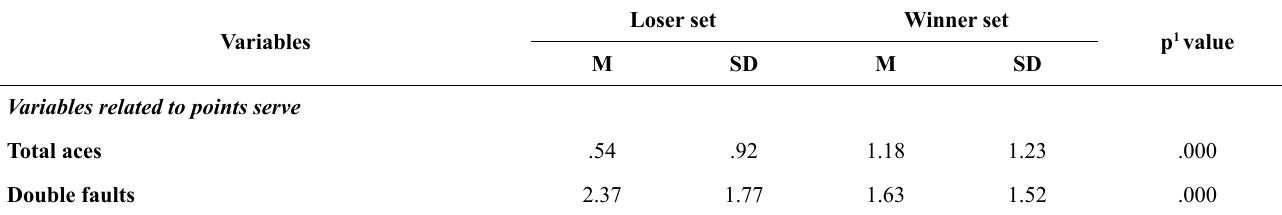
Table 2. Differences between winning and losing wheelchair tennis players in game statistics from the 2012 Paralympics Games. Media (M) and Standard Deviation